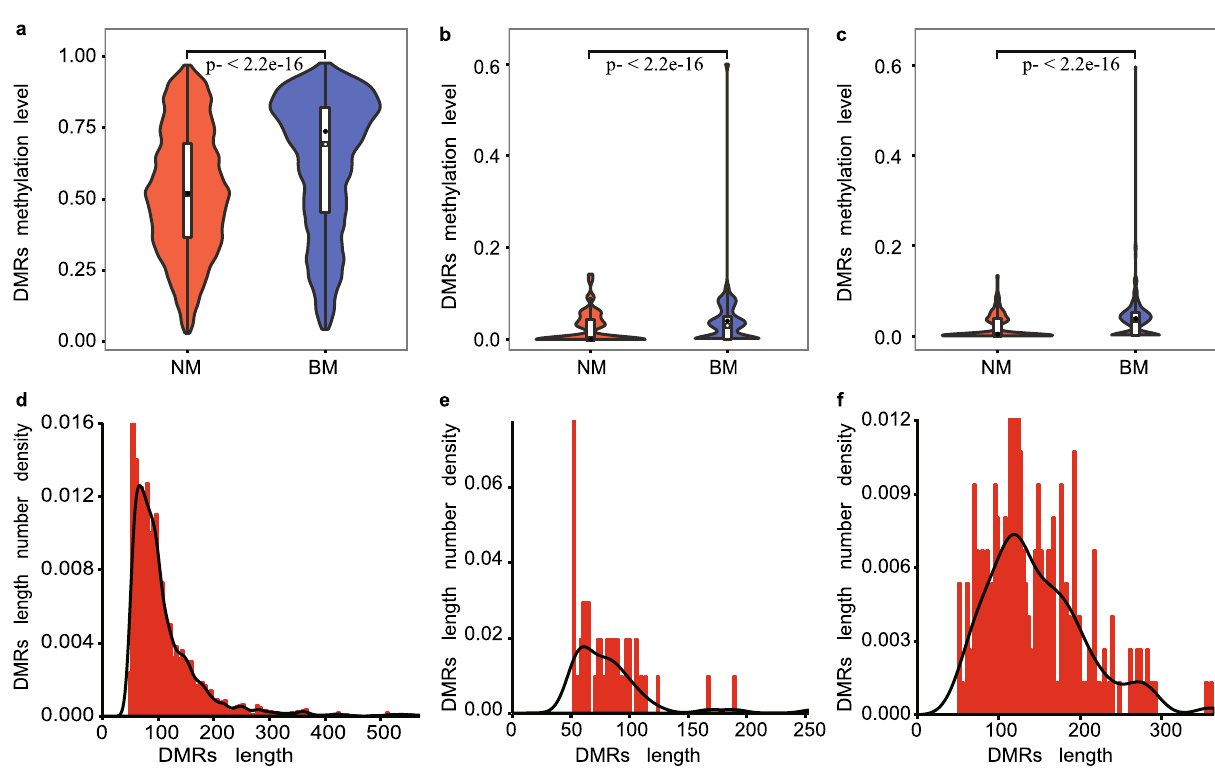
Figure 4. Methylation levels and length number densities of CG, CHG and CHH context DMRs in muscle. ( a ) Violin plot of DMRs methylation level in CG context ( p value < 2.2e−16). ( b ) Violin plot of DMRs methylation level in CHG context ( p value < 2.2e−16). ( c ) Violin plot of DMRs methylation level in CHH context ( p value < 2.2e−16). ( d ) DMRs length number density in CG context. ( e ) DMRs length number density in CHG context. ( f ) DMRs length number density in CHH